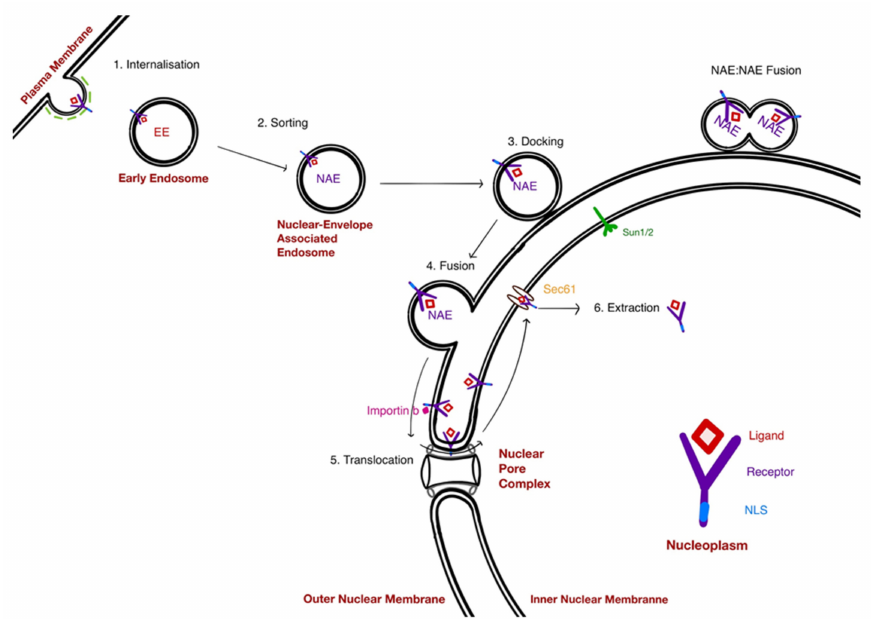
Figure 3. Steps in the NAE pathway. (1) Internalisation via clathrin-dependent or clathrin-independent mechanisms; (2) sorting at the early endosomal stage; (3) docking of NAE to the nuclear envelope; (4) fusion of NAE and the ONM; (5) translocation of the receptor from the ONM to the INM via the NPC; (6) extraction of the receptor from the INM membrane into the